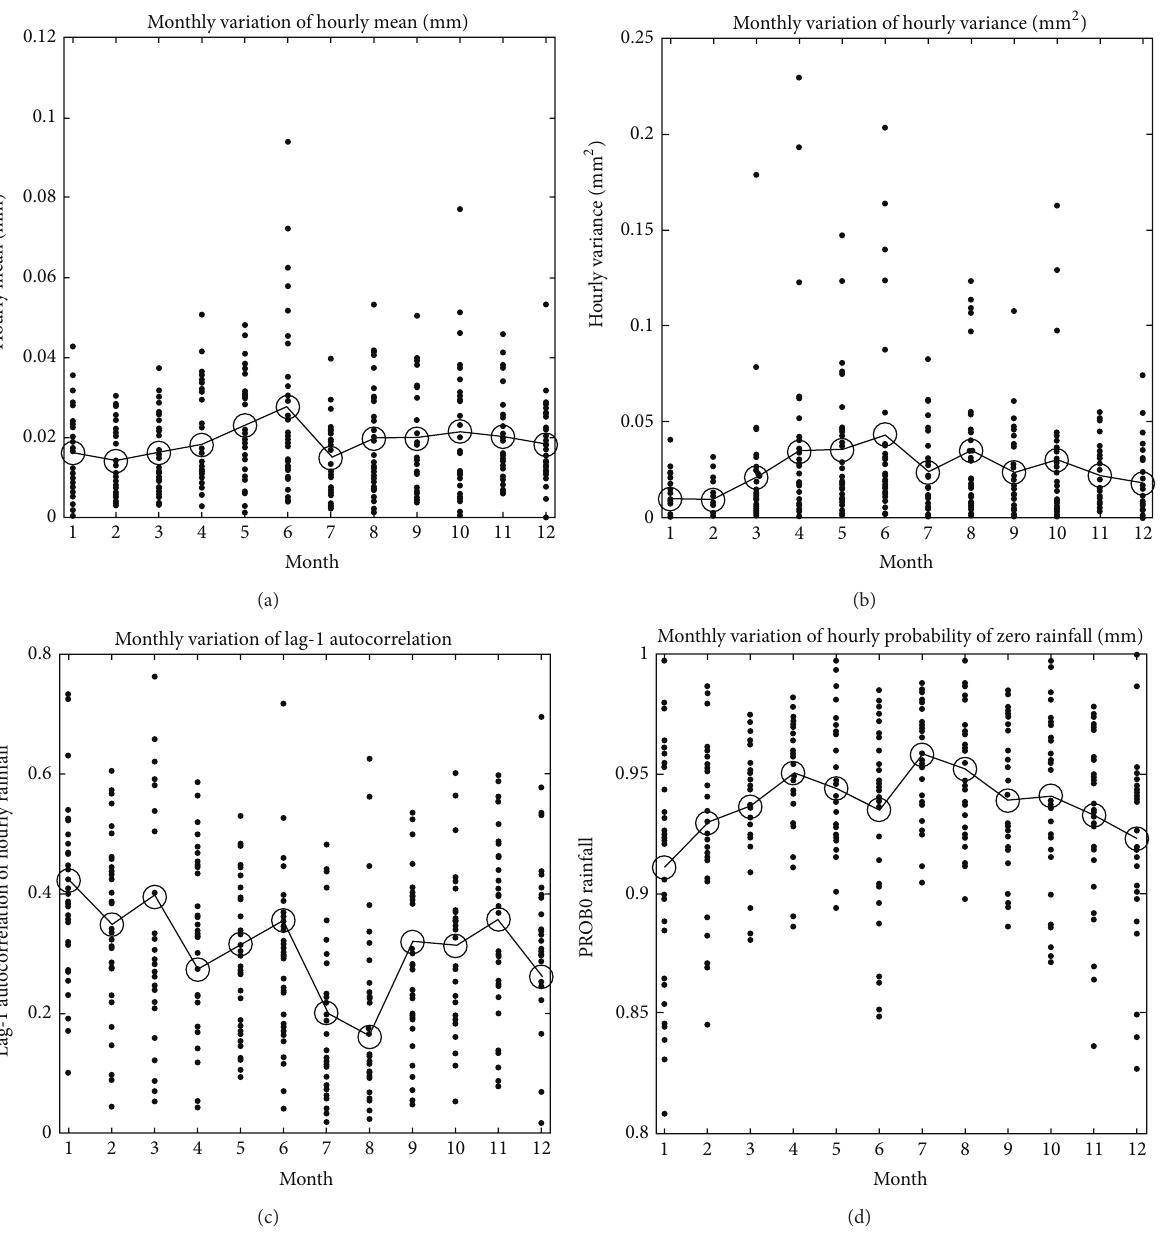
Figure3:MonthlyvariationinhourlyrainfallstatisticsatthegaugeTX-4300.Smalldotsineachplotrepresentrainfallstatisticscorresponding to a given month of a given year. Hollow circles connected with a solid line represent the rainfall statistics for a given month over the entire recording